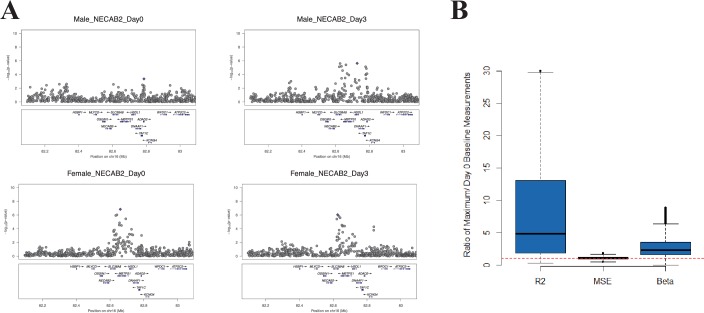
At some loci, the magnitude of the genetic effect changes after the experimental perturbation.(A) A specific example of this phenomenon: local Manhattan plots for the gene NECAB2 before and on day 3 after vaccination in each of the two cohorts, showing an increase in the magnitude of the genotype effect (R2g) after the experimental perturbation. (B) An increase in R2g after the experimental perturbation is a general feature of the SNP-transcript pairs that show a strong cis-eQTLs and a transcriptional response to vaccination (left). The within-genotype variance is unchanged (MSE, center), while the strength of the genotype effect on expression (slope of the additive association; β, right) increases, suggesting that the latter is the main driver for the observed increase in the genetic effect after vaccination.